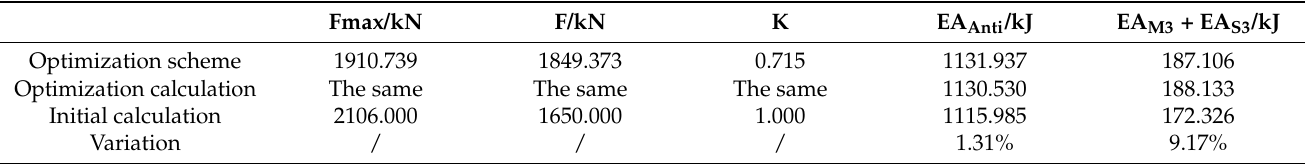
Table 6. Comparison of results before and after